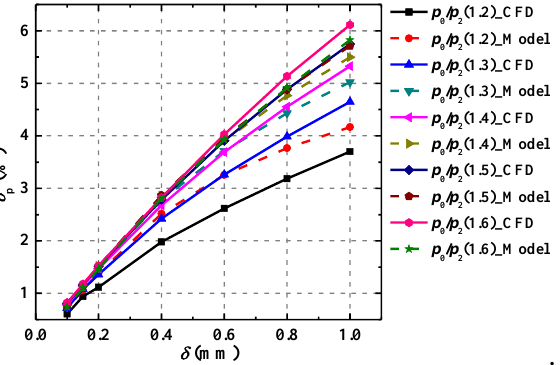
Figure 21. Variation of the attenuation magnitude of the reflected shock pressure ratio with the leakage gap